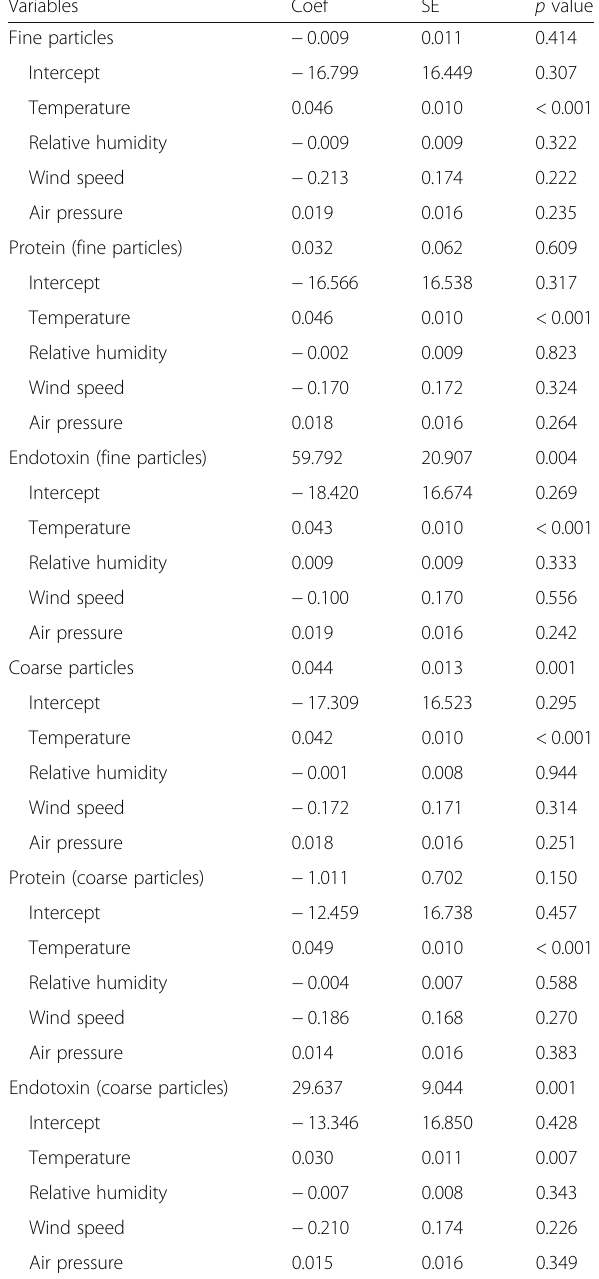
Table 4 Results of Poisson regressions of air pollutants and meteorological factors on emergency department